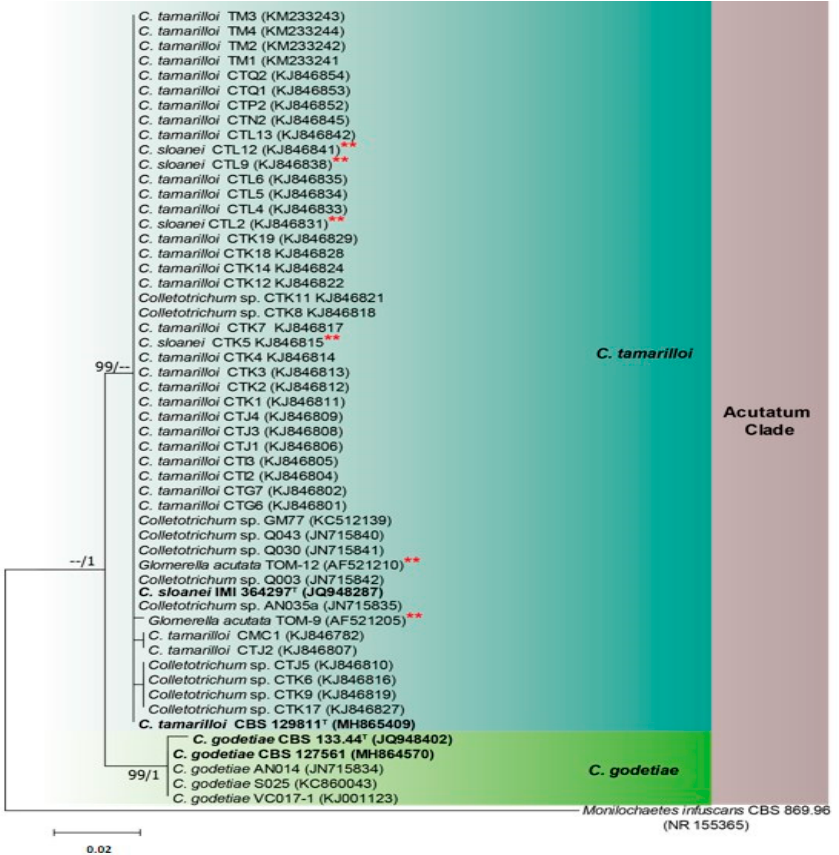
Figure 5. An ML tree of the acutatum clade that includes the species reported in northern South America (Colombia, Ecuador, Peru, and Venezuela). The tree was created based on the alignment of ITS (442 bp). The GenBank accession numbers of sequences retrieved from the database are given in parentheses. Reference strains are presented in bold. Branch lengths are proportional to phylogenetic distance. The best substitution model for ML was determined to be T92. Bootstrap support values/Bayesian posterior probability scores above 70%/0.95 are indicated on the nodes. The tree was rooted to Monilochaetes infuscans CBS 869.96. T = Ex-type strain. ** Isolates are probably mislabeled in GenBank. Table 1. Colletotrichum species reported in Colombia, Ecuador, Peru, and Venezuela.